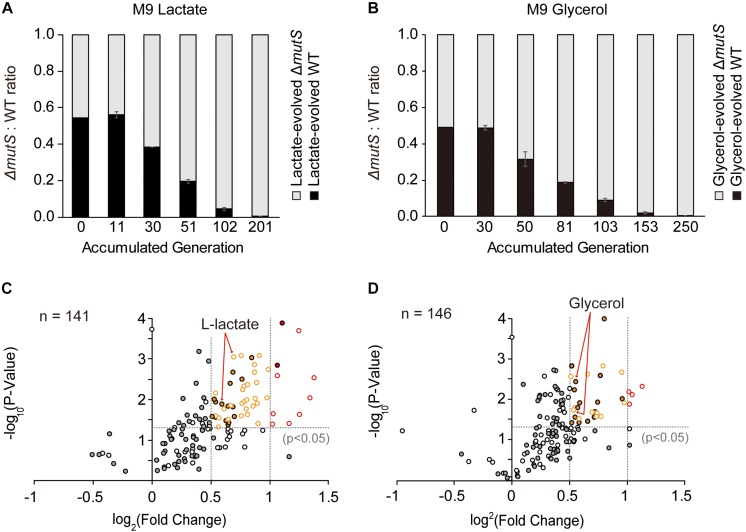
Fitness landscape of the evolved mutator and the wild-type. (A,B) Ratio-wise representation of the proportion of the evolved wild-type versus the evolved mutator strains in the course of competition experiment. Each panel depicts competition experiments between (A) lactate-evolved mutator and wild-type or (B) glycerol-evolved mutator and wild-type. (C,D) Relative growth rates of the (C) lactate- and (D) glycerol-evolved E. coli wild-type and ΔmutS strains on a panel of nutrient substrates. Volcano plots indicate the logarithmic ratio of growth rates between the lactate- and the glycerol-evolved strains relative to the ancestral strains. Dotted line intersecting the Y-axis is the baseline of significance (p < 0.05). Substrates with negative growth profile were omitted from the analysis. Filled and blank circles each represent the wild-type and the ΔmutS strains. The substrates that lie above the baseline of significance were classified in accordance with the magnitude of fitness improvement in log2 scale; those that lie between log2 (0.5) and log2 (1) (between the dotted lines intersecting the x-axis) were shown in yellow, and above log2 (1) in red.